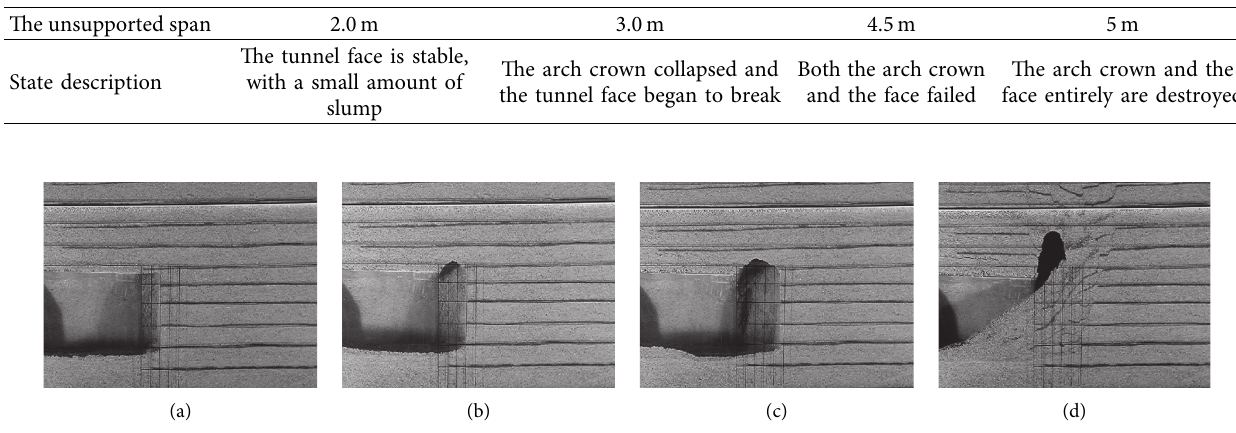
Table 2: Stability of tunnel face and vault under different unsupported span.